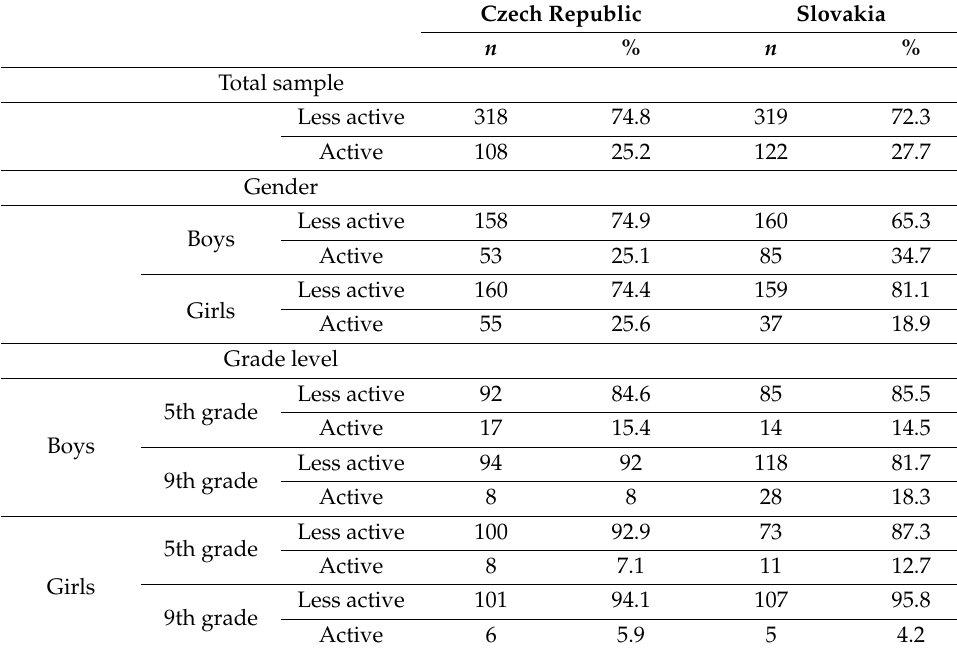
Table 2. Distribution of physically active and inactive